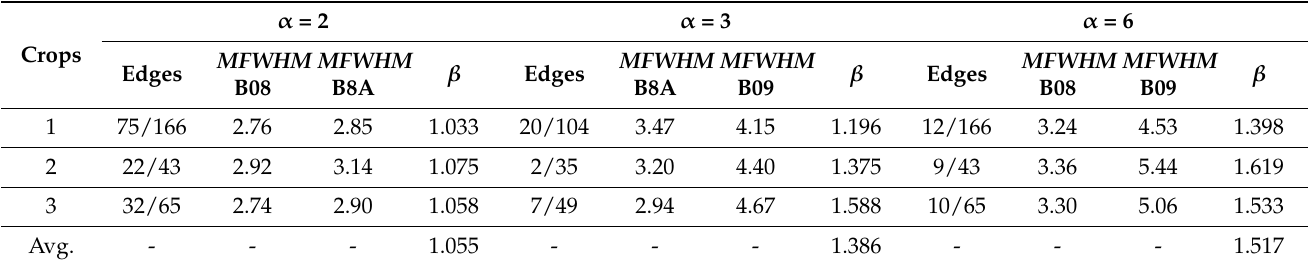
Table 3. ELF measurements of three cropped regions for B08 and B8A ( α = 2), B8A and B09 ( α = 3), and B08 and B09 ( α =